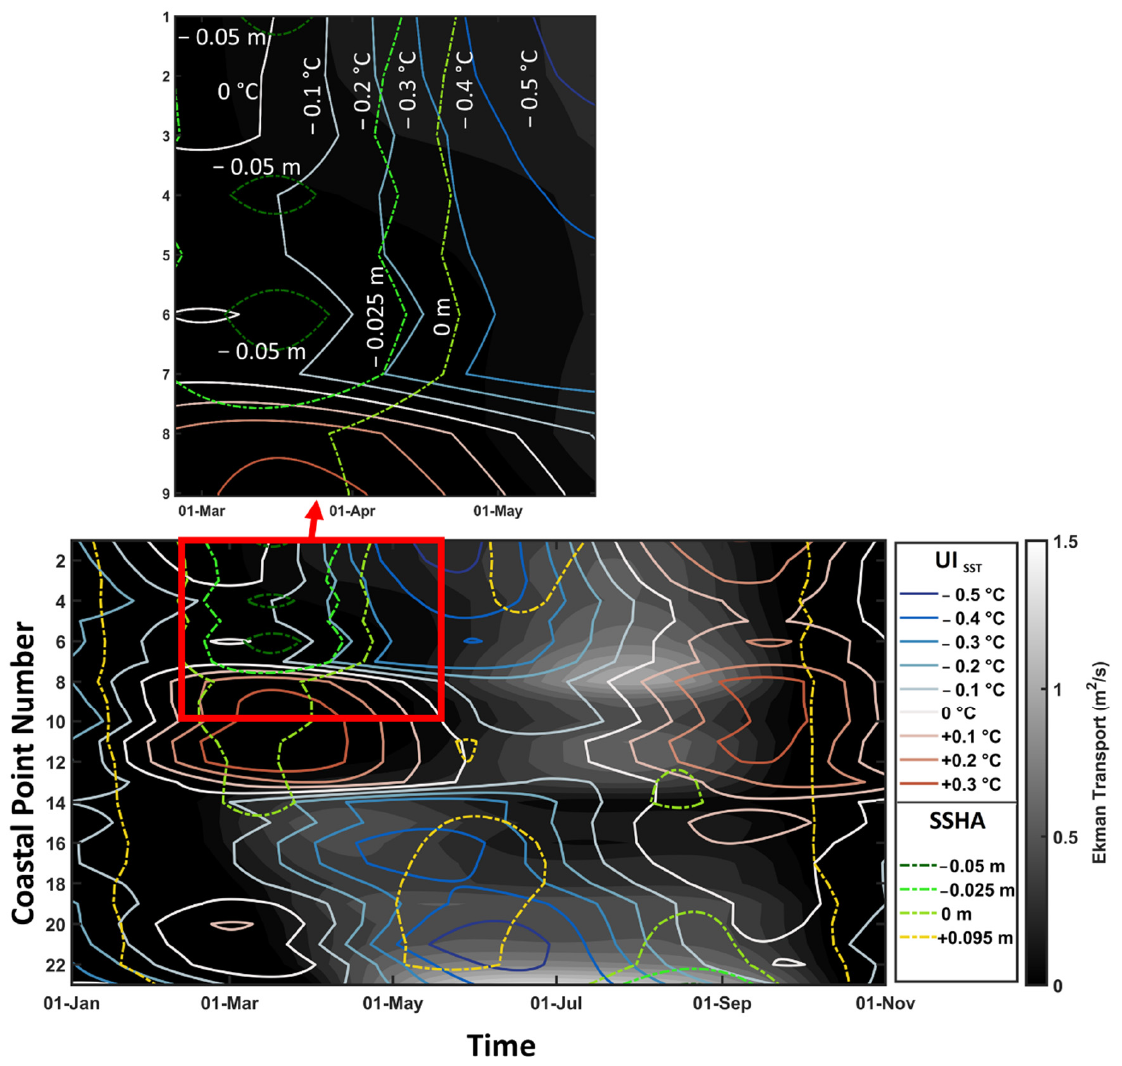
Figure 6. Climatology of ET with UI SST contour (solid lines) and SSHA contours (dashed line) considering all the bandpass-filtered variables. Inset: Premonsoon UI SST and SSHA in the northern section of the coast.